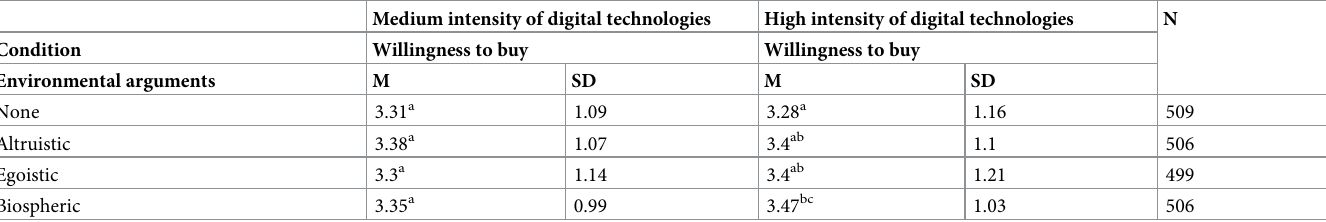
Table 3. Willingness to buy food produced by farms based on environmental arguments.